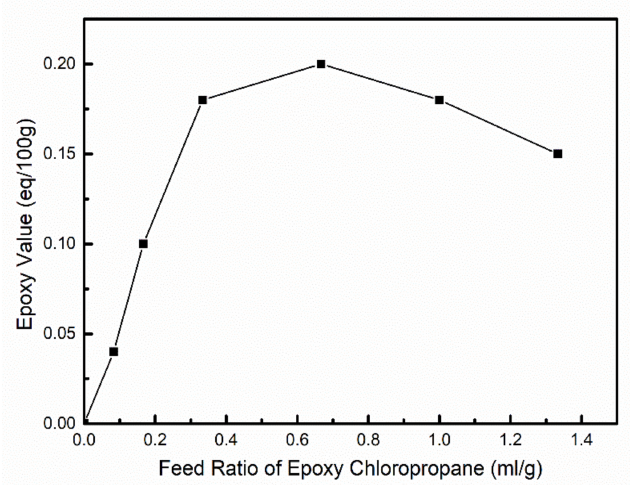
Figure 6. E ff ect of epoxy chloropropane feed ratio on the epoxy value of